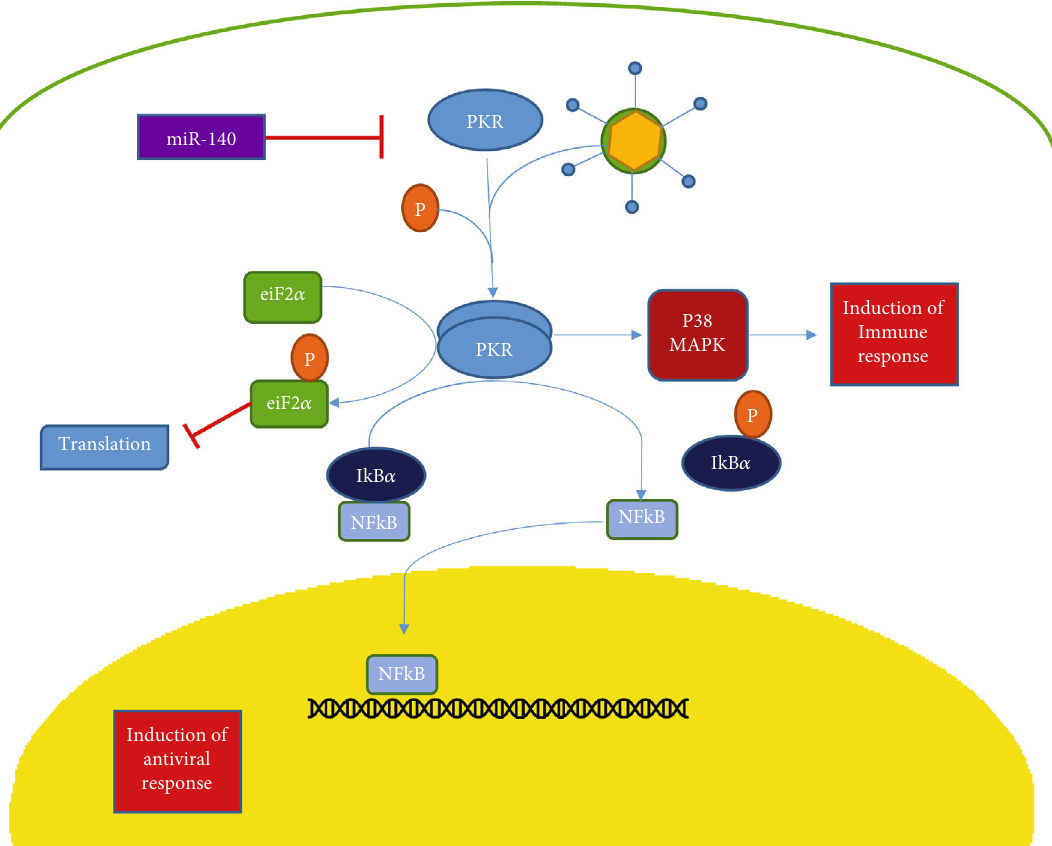
Figure 2: Overview of PKR signaling pathway. PKR is a member of innate immune system which in human is encoded by EIF2AK2 gene. After reovirus infection, PKR is phosphorylated and results in phosphorylation of eiF2 α protein. eiF2 α is a translation initiation factor and its inhibition leads to further cellular mRNA translation. PKR also results in nuclear placement of NF- κ B which is a transcription factor and sets up an antiviral state in cell. miR-140 blocks PKR and inhibits its signaling pathway by degrading